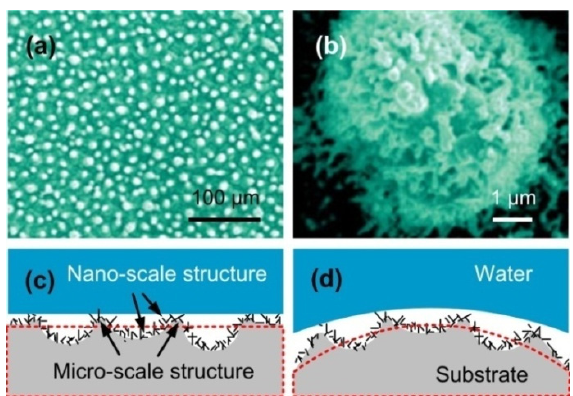
Figure 2. Surface morphology of the lotus leaf and schematic diagram of dual-level structure: ( a ) and ( b ) Micron-sized mastoid and nano-sized branching structures (Reproduced with permission from [40]. Copyright Wiley-VCH, 2002); ( c ) designed plane surface with dual-level structure; ( d ) designed convex surface with dual-level structure.